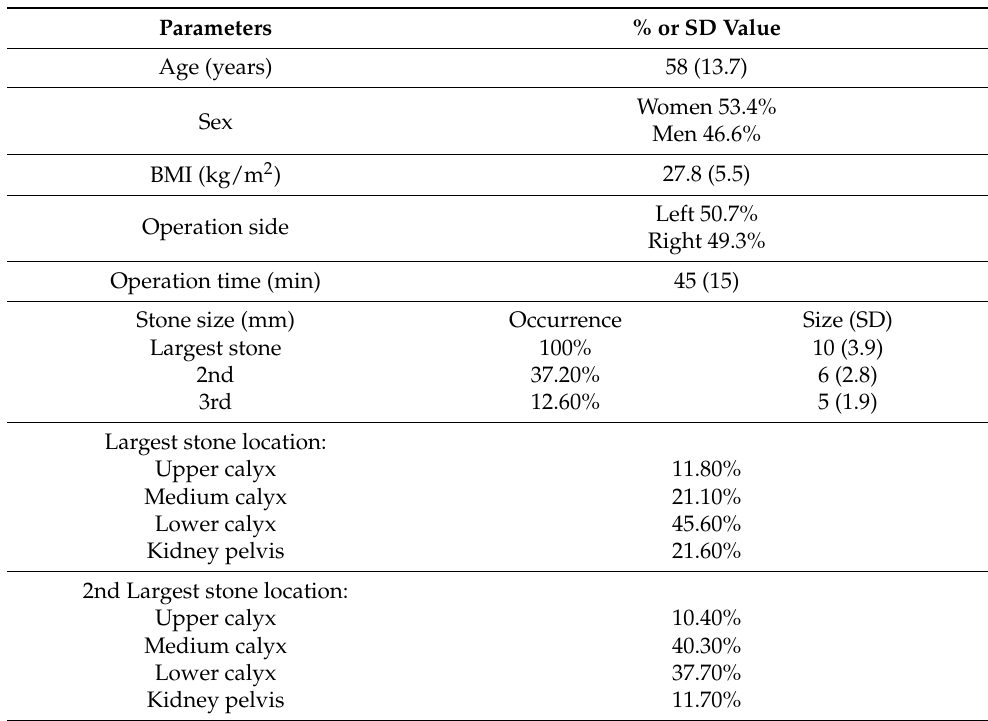
Table 1. Study group